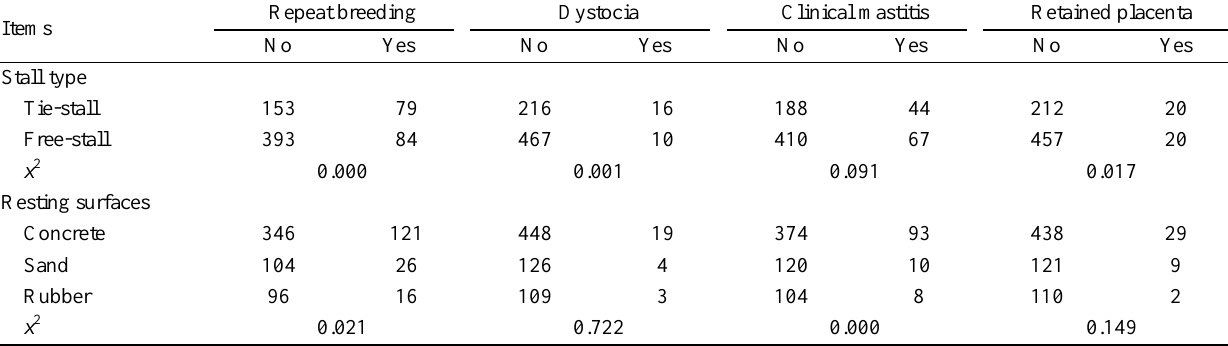
Table 3. Associations between stall and resting surface types and some health problems Repeat Items